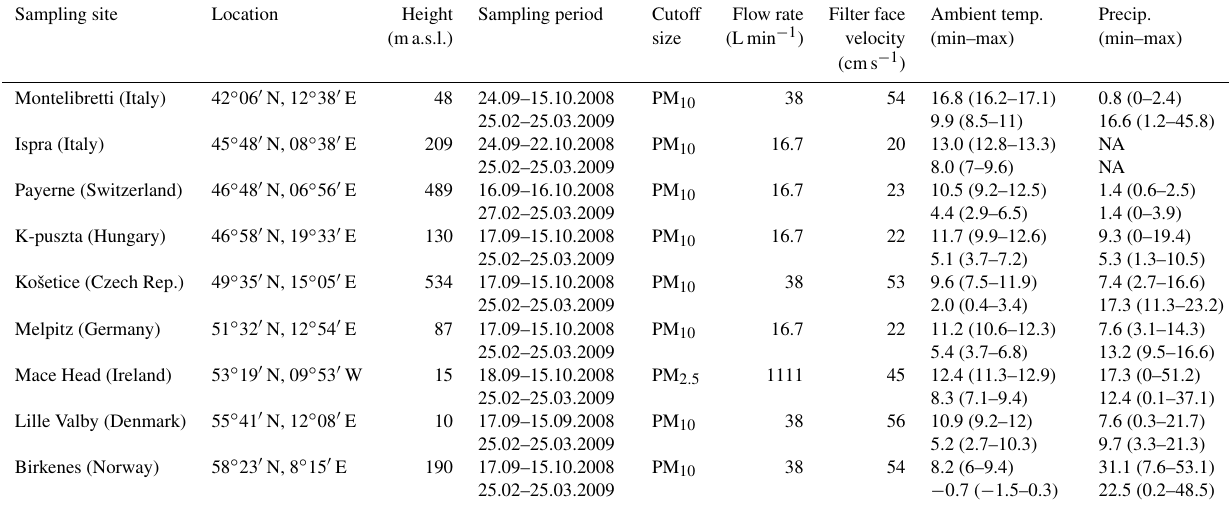
Table 1. Location of the nine European rural background sites that participated in the fall 2008 and winter/spring 2009 sampling periods. The sites are ordered by latitude from south to north. NA denotes data that are not available. Sampling